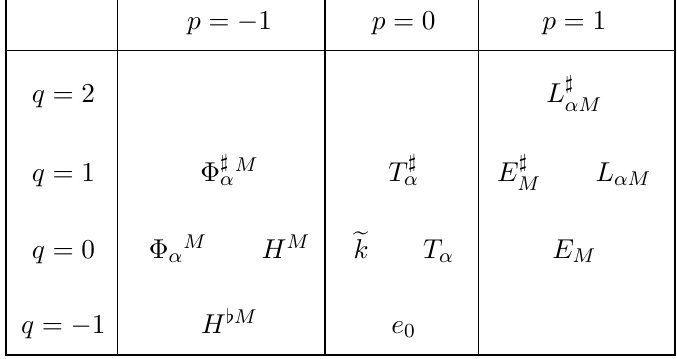
Table 4 . Basis elements for S ( g + ) at p = (cid:0) 1 ; 0 ;